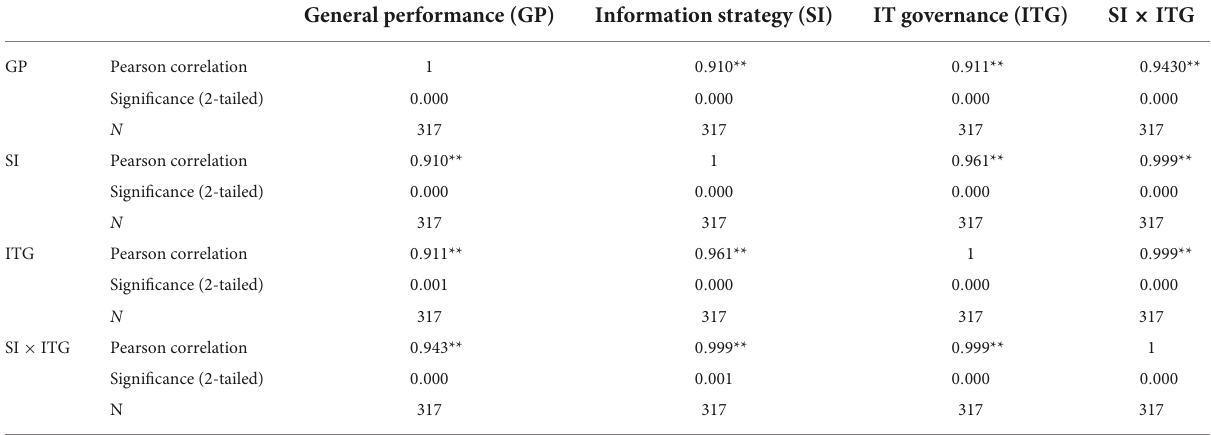
TABLE 6 Information strategy, IT governance, and corporation